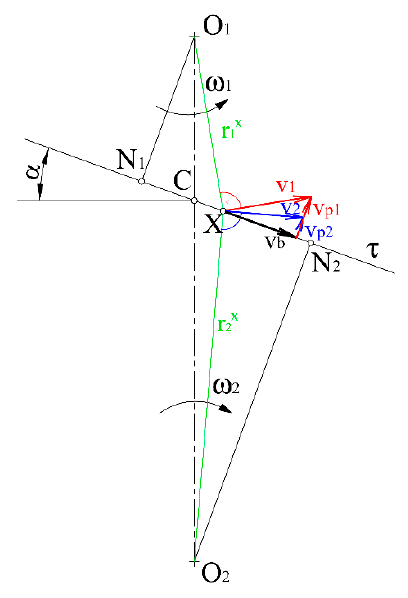
Figure 3. Velocity relations in intermeshing spur gears.